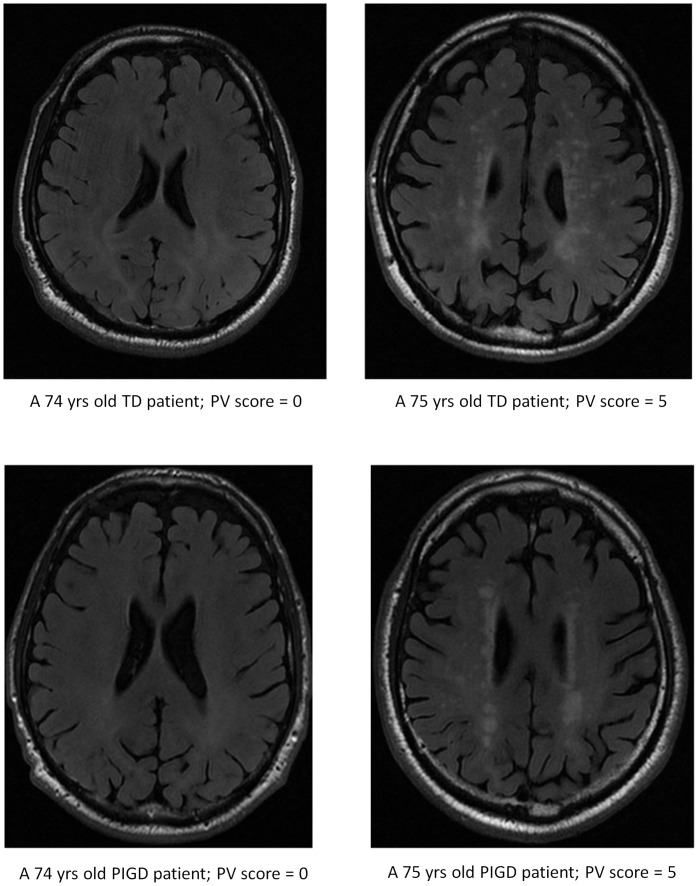
An example of periventricular WMHs in two patients with the PIGD subtype and two patients with the TD subtype.As shown, a subject with PIGD had a low score on the Scheltens scale, while another had a relatively high score (5 out of max. possible 6). Similarly, one patient in the TD group had a low score, while another had a relatively high score. These examples are consistent with the lack of an association between the Scheltens’ scoring and PIGD and TD subtypes that was seen in general.